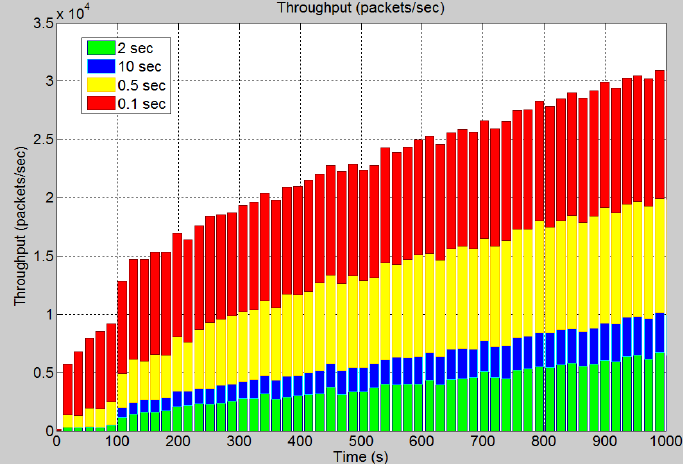
Figure 19. Case 4: Throughput (packets/sec) for different inter arrival time.